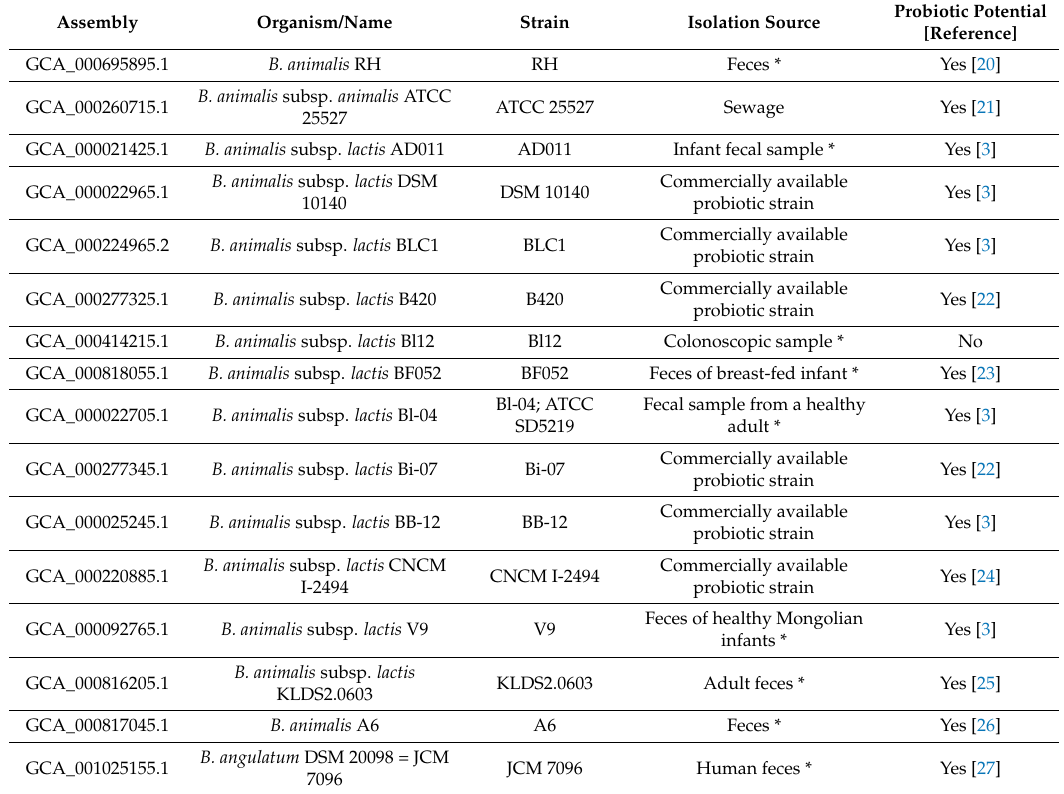
Table 1. List of the 56 probiotic and human-gut strains of bifidobacteria (PHBifs) used for the